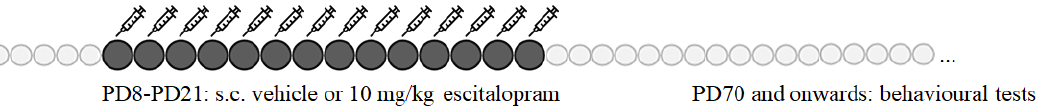
Figure 1. All rats were divided into four groups and received a total of 14 (once daily) s.c. administrations of either saline (vehicle, n = 12 and n = 12 for male and female rats, respectively) or 10 mg/kg of escitalopram ( n = 12 and n = 12 for male and female rats, respectively), which started on postnatal day 8 (PD8) and continued until PD21 (treatment days are marked as dark circles). From PD21 until adulthood (PD70) all animals were left undisturbed in their home-cages (marked as white circles). From PD70 onwards, the following behavioural tests were performed: sucrose and quinine preference tests, voluntary intermittent alcohol consumption and effect of melatonin administration on voluntary alcohol consumption (please note that escitalopram-treated female rats remained smaller than their control counterpart rats throughout the sucrose and quinine preference tests and the entire intermittent alcohol consumption study, and hence these rats were not used in the final melatonin treatment experiment).